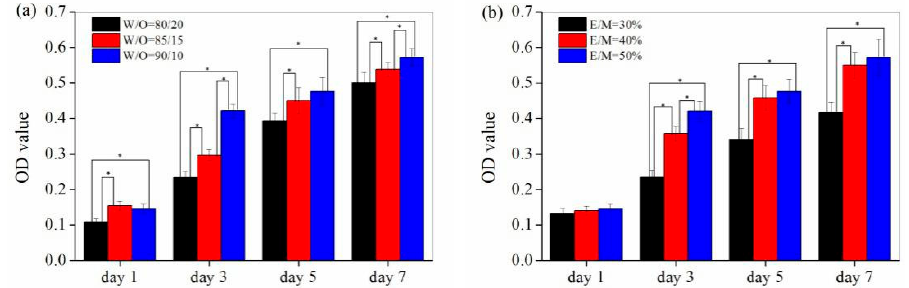
Figure 8. Cell Proliferation curves of A549 cells on different scaffolds. ( a ) PolyHIPE scaffolds fabricated with different W/O ratio. ( b ) PolyHIPE scaffolds fabricated with different emulsifier amount. * Significantly difference p < 0.05 (equal variance t -test).